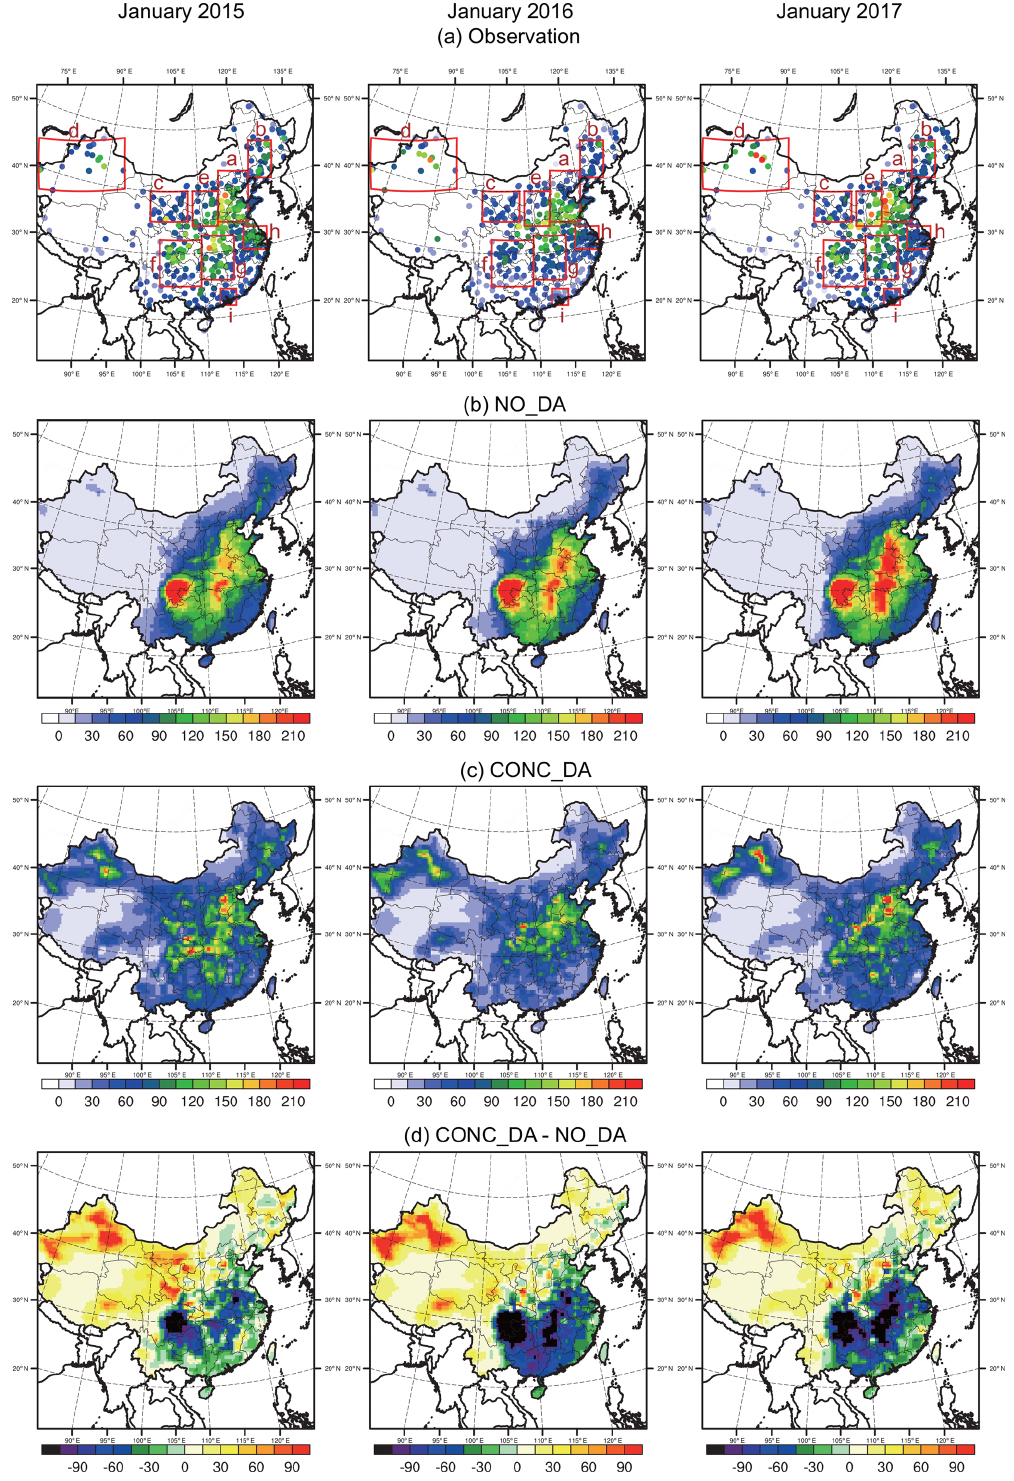
Figure 3. Observed and modeled monthly average PM 2 . 5 concentrations (unit: µgm − 3 ) for January 2015 (left), 2016 (middle) and 2017 (right). Regions defined in red rectangles in (a) are as follows: a – NCP (North China Plain), b – NEC (northeastern China), c – EGT (Energy Golden Triangle), d – XJ (Xinjiang), e – FWP (Fenwei Plain), f – SB (Sichuan Basin), g – CC (central China), h – YRD (Yangtze River Delta) – and i – PRD (Pearl River